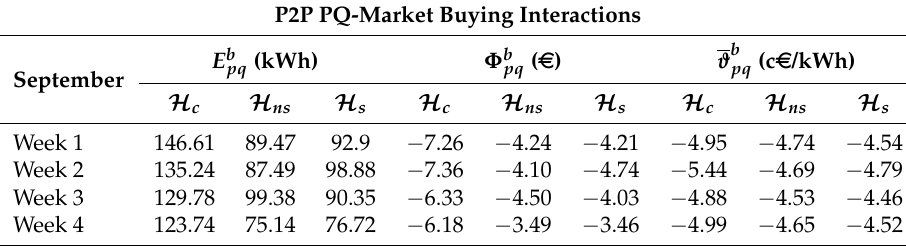
Table 7. P2P power quota market